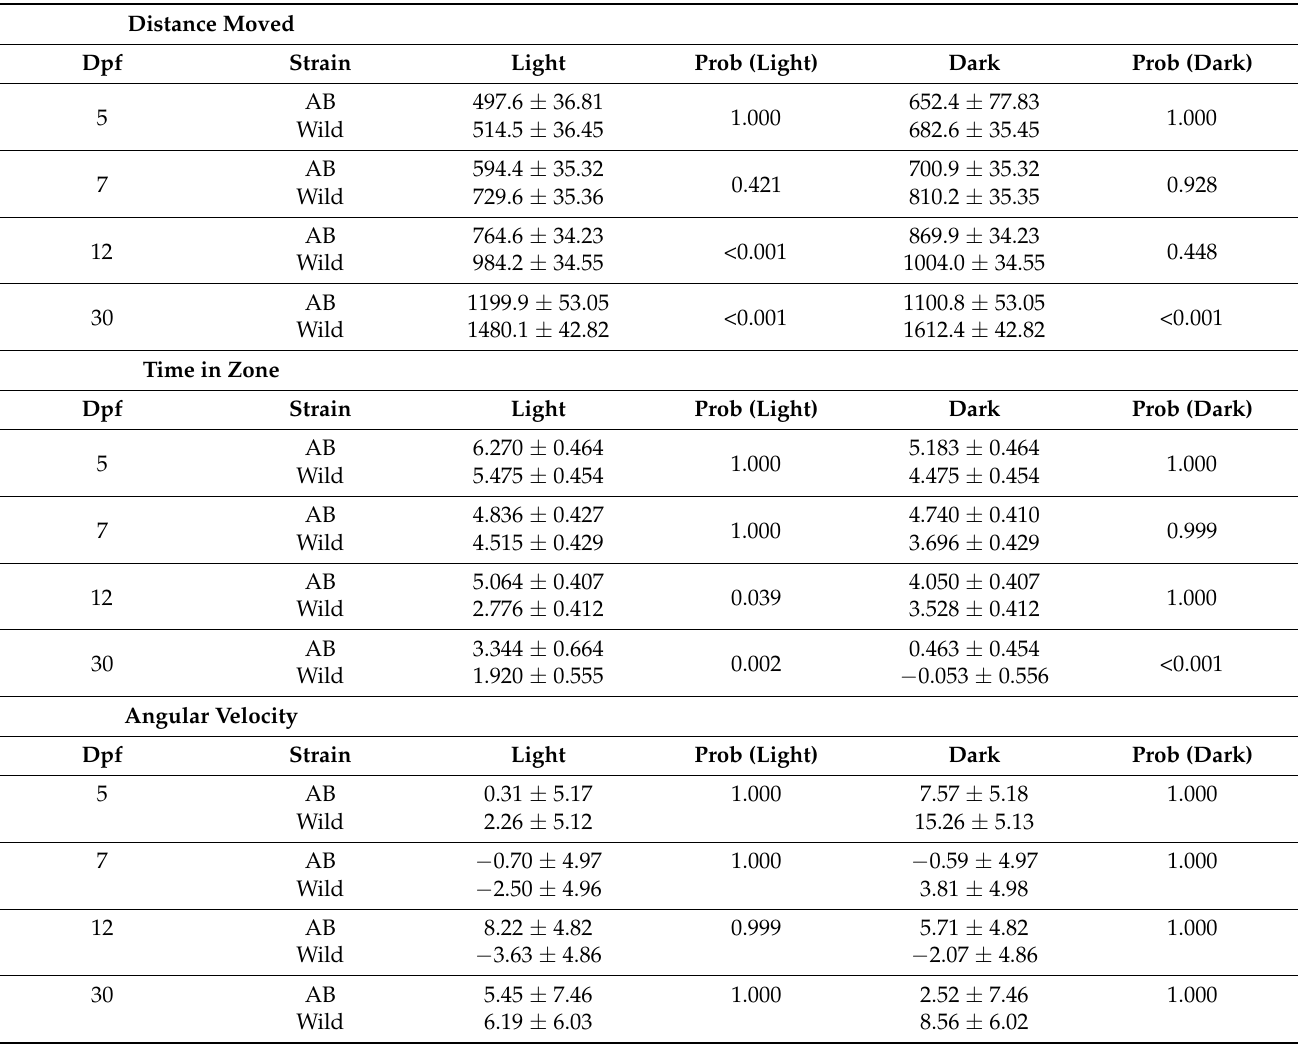
Table 2. Differences between AB and wild strain in distance moved, time in zone and angular velocity during light and dark periods. The number of observations in each group was 36 in all cases. The level of significance was adjusted using Sidak method. The means are least square means, using fish length as a covariate. Estimates are given as mean ±